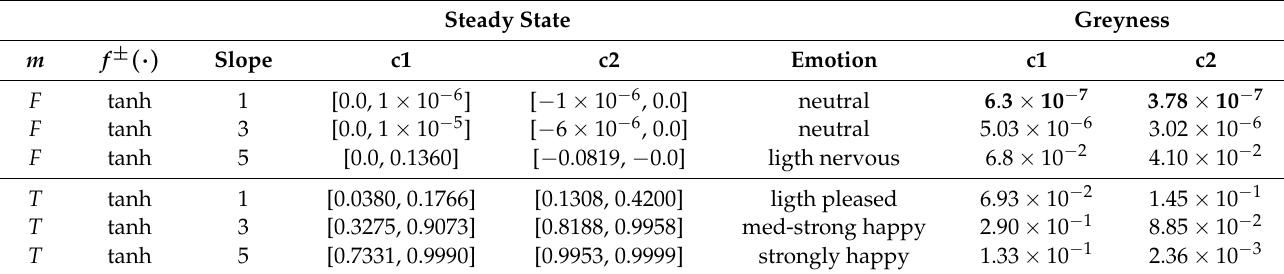
Table 2. Results of experiment